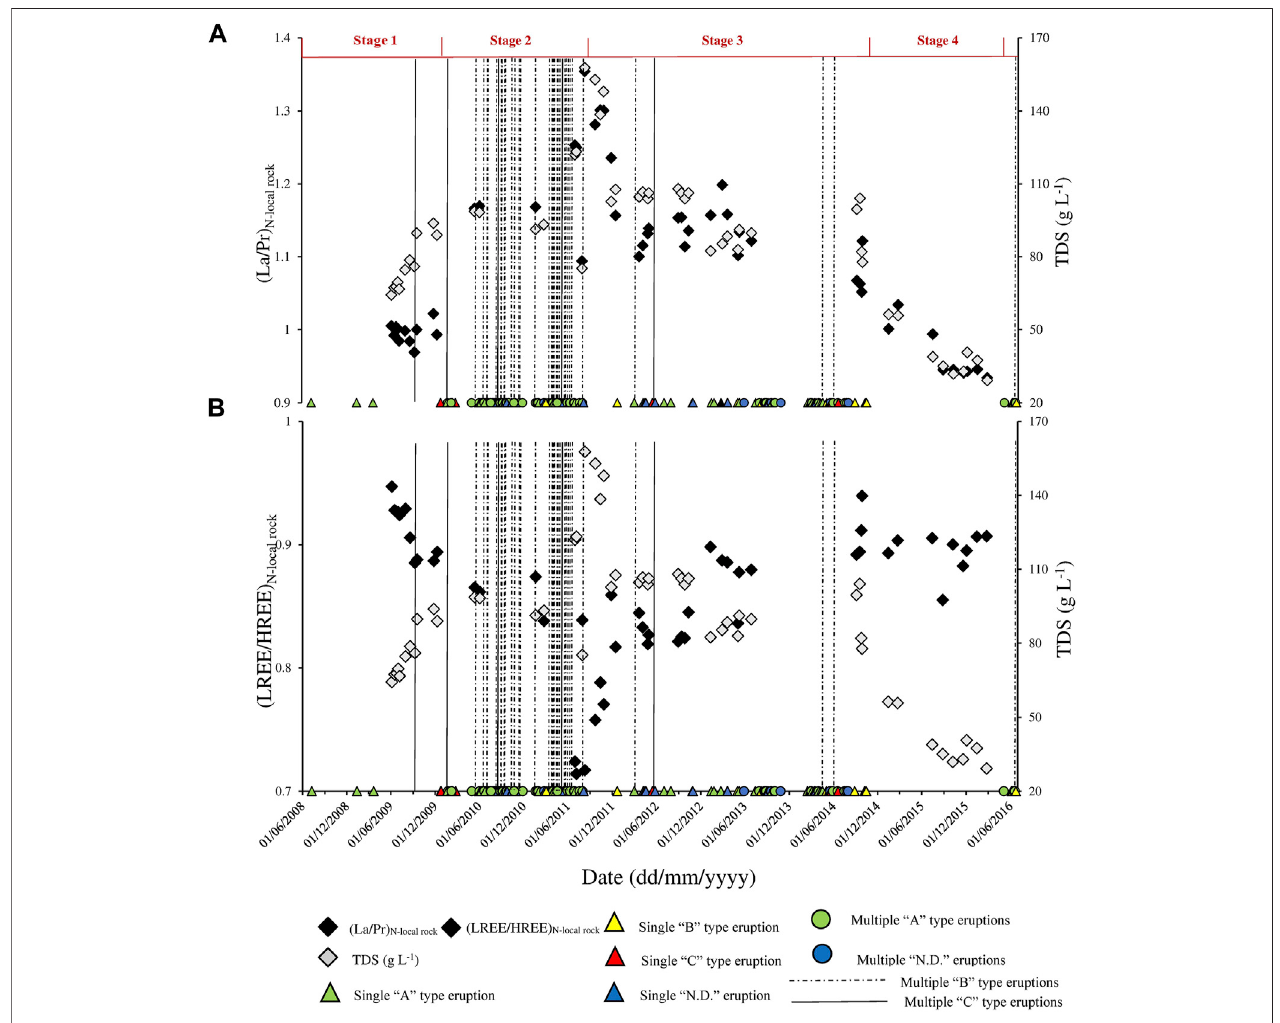
FIGURE 7 | (A) (La/Pr) N-local rock and TDS vs. time. (B) (LREE/HREE) N-local rock and TDS vs. time.